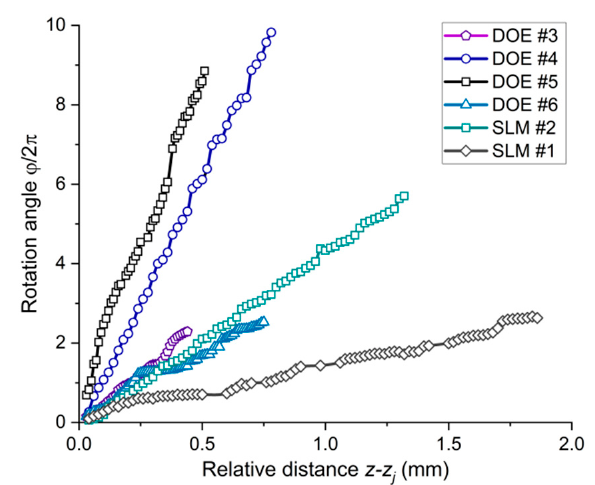
Figure 9. Angle of spectral Gouy rotation for extended propagation distances (numbers correspond to configuration numbers in Table 1). The increase of phase appears to be nearly linear.